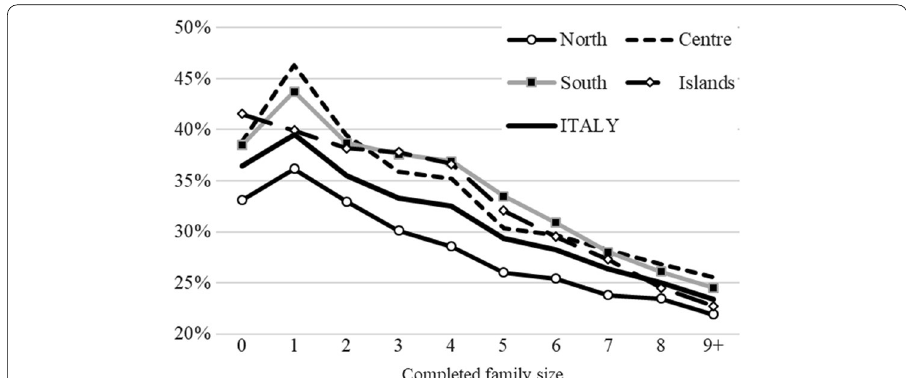
Fig. 2 Survival chances between 1931 and 1961 of the cohorts born in the years 1887–1891 by CFS, in Italy (ever-married women aged 40–44 years and over at the start of the period and 70–74 years and over at its end). Ever-married women observed in 1931 at the 40–44 years, and in 1961 at the 70–74 years. Source : Istat (1936, 1974) and authors’